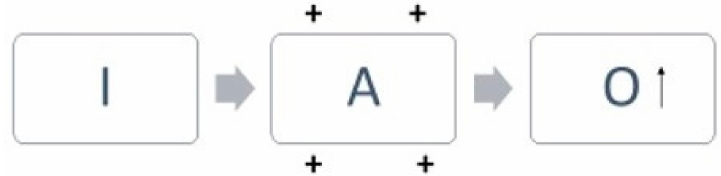
Figure 3. Process evolution type